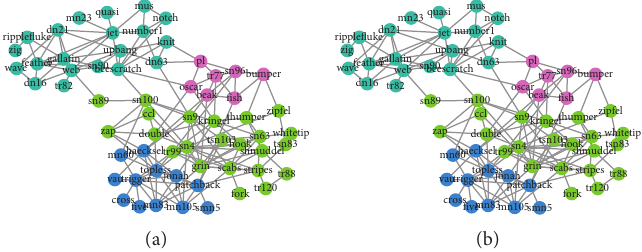
Figure 6: The Dolphin social network: (a) the ground-truth community structure; (b) the community structure obtained by